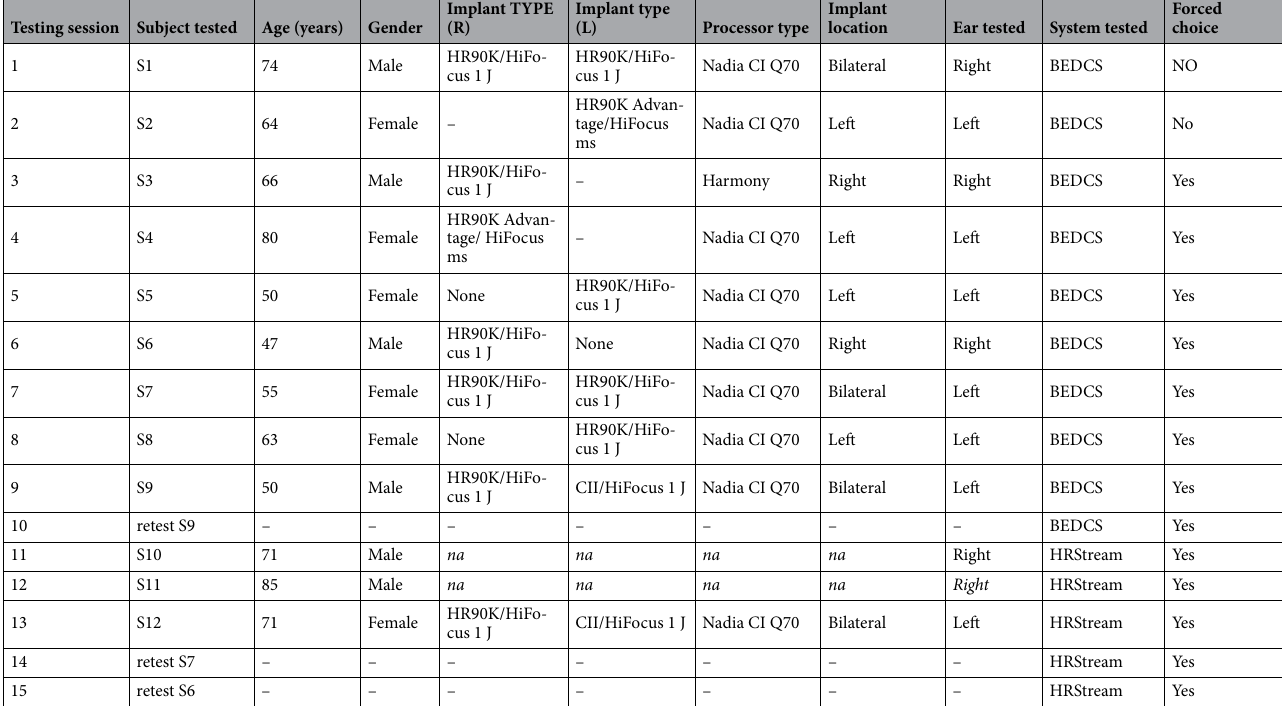
Table 3. Subject demographics for each testing session. Sessions 10, 14, and 15 were retests of previously tested individuals. The entry of “ na” indicates that a patient did not have their implant information available to provide us with the relevant testing